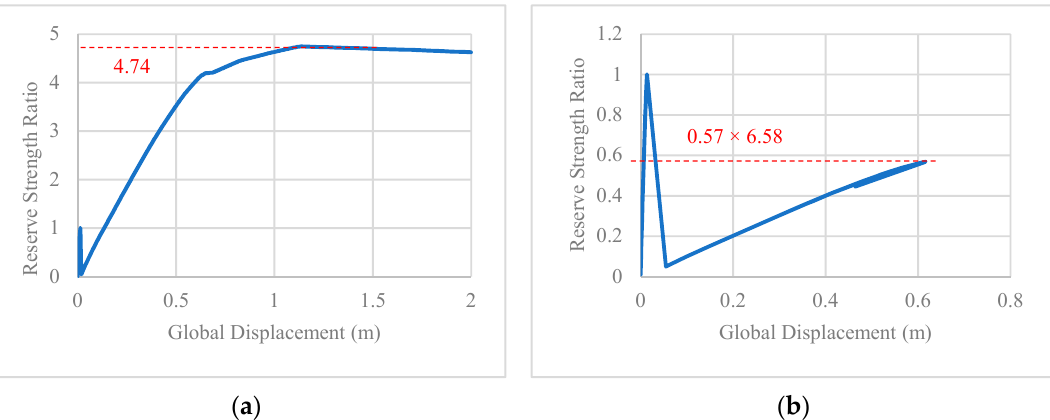
Figure 8. Global load versus global displacement for PK4-88: ( a ) PK4-88: without wave-in-deck load; ( b ) PK4-88: with wave-in-deck load.